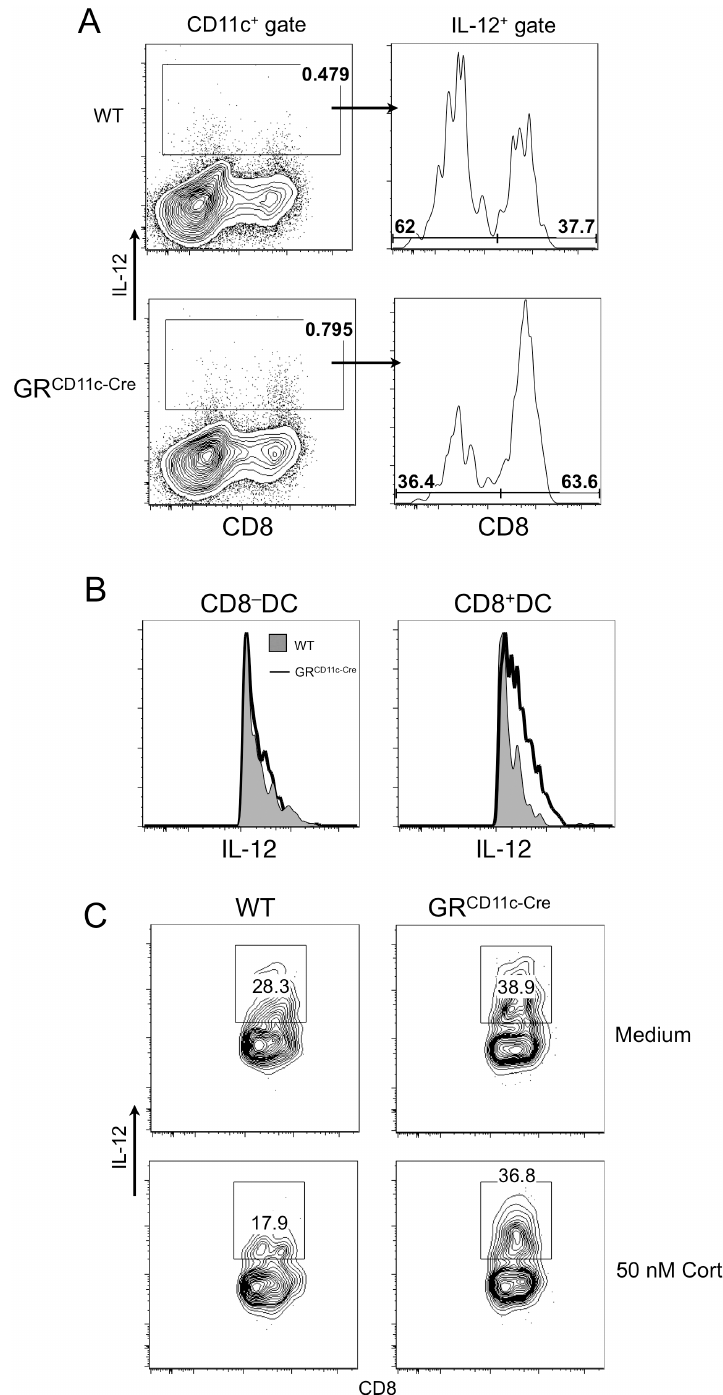
Fig 3. GC suppresses in vivo IL-12 production by CD8 + DCs. (A) Six hr after LPS challenge, WT and GR CD11c-cre splenocytes were analyzed for intracellular IL-12 levels. The right panels are histograms of CD8 staining of CD11c + IL-12 + cells. (B) Intracellular IL-12 levels in CD8 − and CD8 + DCs between WT (shaded) and GR CD11c-cre (solid line). One representative pair of a group of three is shown. (C) GC suppression of IL-12 production by CD8 + DCs ex vivo. Splenocytes were prepared from mice 3 hr after LPS injection and cultured with Brefeldin A in the presence or absence of corticosterone for 4 hr. Intracellular IL-12 levels on gated CD8 + DCs from one experiment are shown. The data are representative of three independent pairs of